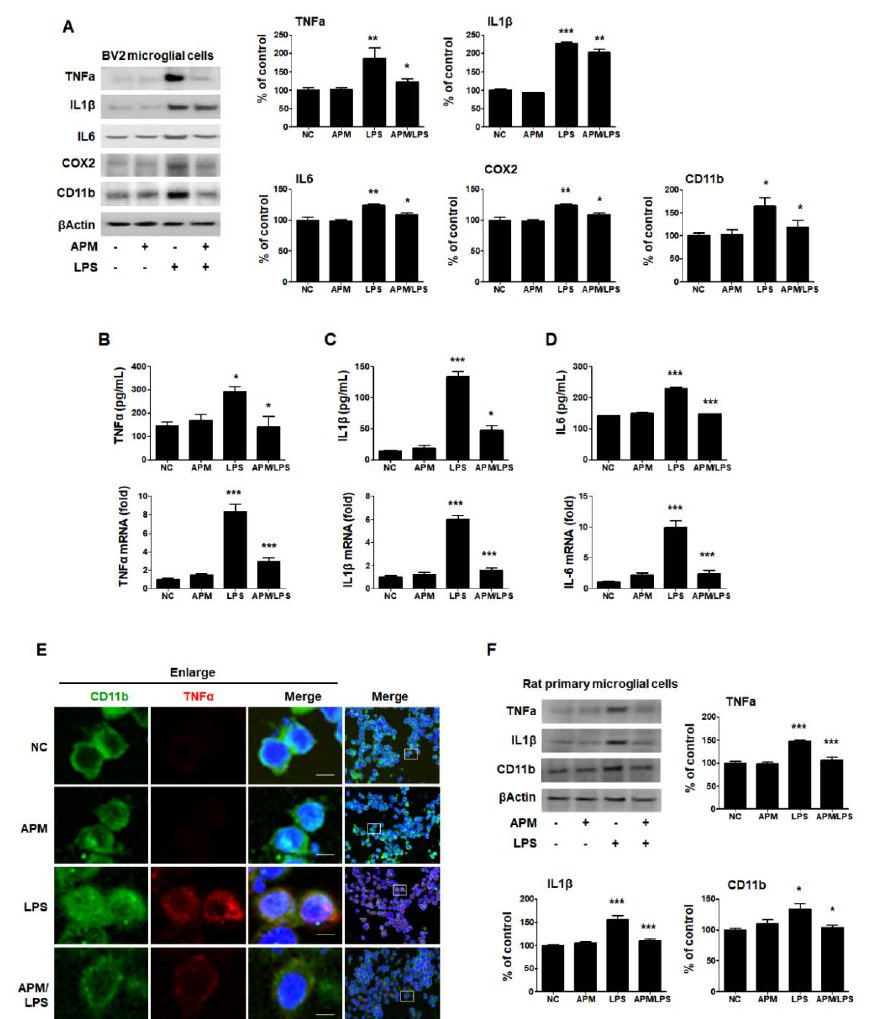
Figure 1. APM inhibits LPS-induced proinflammatory responses in LPS-stimulated BV2 and rat primary microglial cells. Cells were incubated in the presence or absence of APM for 1 h and then treated with LPS for 12 h. CD11b, TNFα, IL1β, IL6, and COX2 expression was significantly inhibited in LPS-stimulated BV2 microglial cells by APM administration ( A ). APM strong suppressed LPS-induced TNFα ( B ), IL1β ( C ) and IL6 ( D ) production both in extracellular and mRNA levels. Immunofluorescence double staining for CD11b (green) and TNFα (red) localization in BV2 microglial cells ( E ). Cell were counterstained with DAPI (blue). Magnification 400×. Enlarge figure of scale bars: 5 μm. APM strong suppressed LPS-induced TNFα, IL1β and CD11b expression in rat primary microglial cells ( F ). βActin was used to confirm equal sample loading. TNFα, IL1β, IL6,